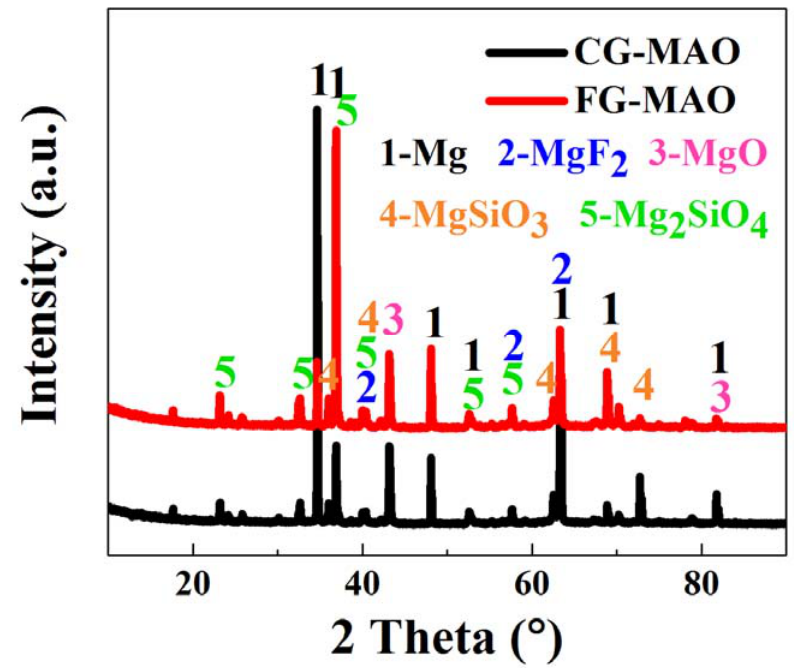
Figure 4. XRD graph of CG ‐ MAO and FG ‐ MAO sample prepared on pure Mg.